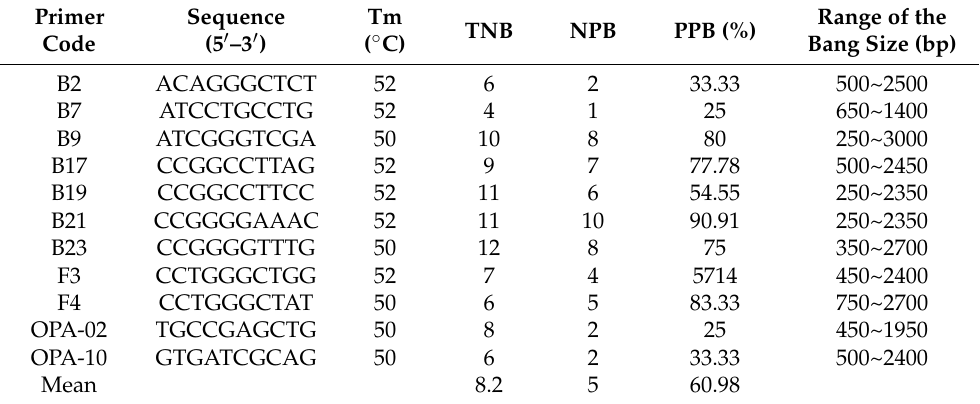
Table 3. Amplification of 11 RAPD markers in 54 castor seed